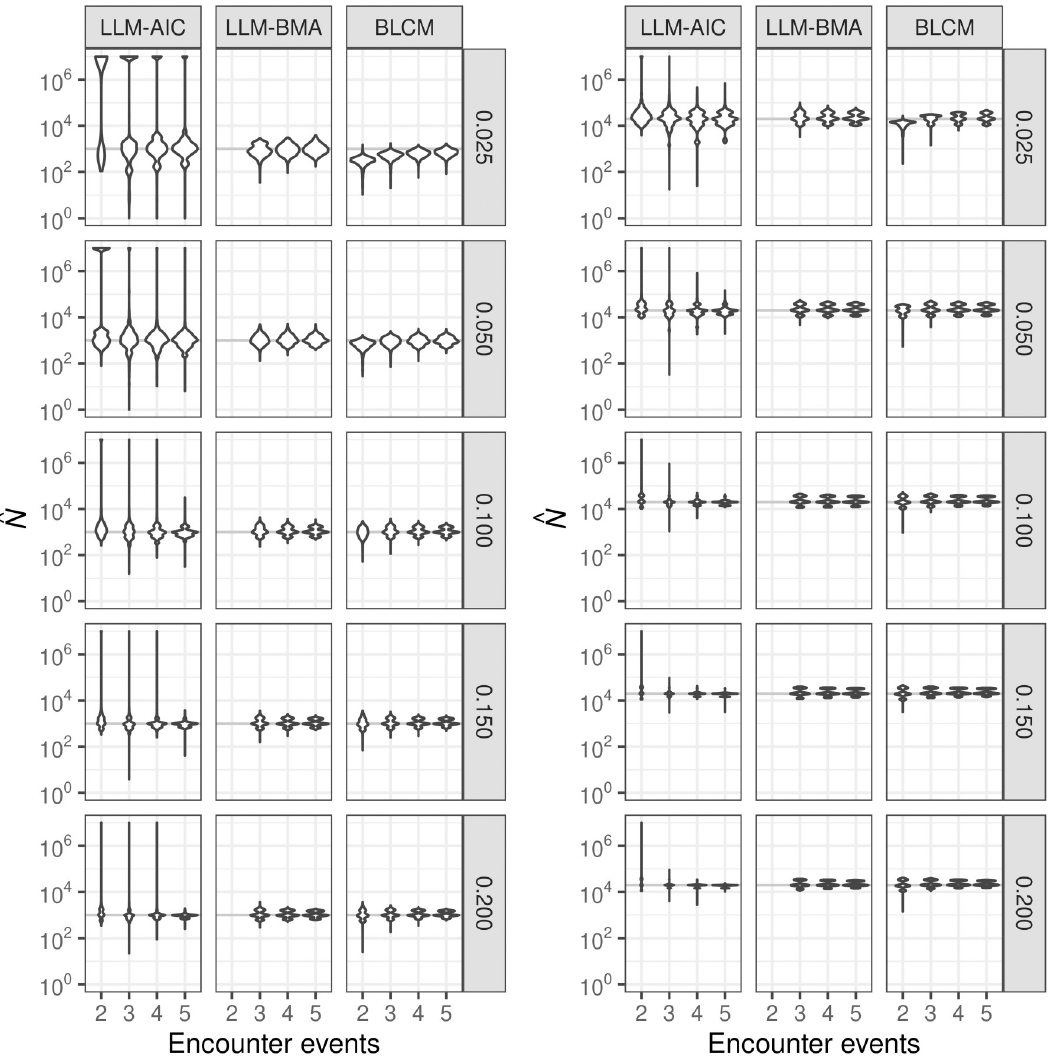
Fig 2. Distributions of estimates the sizes of populations consisting of 1,000 (left) and 20,000 (right) members. Estimation was based on 2–5 encounter event-histories generated from models M probabilities of 0.025, 0.050, 0.100, 0.150 and 0.200 (right margins). LLM-AIC denotes selection of the single best LLM based on AIC, LLM-BMA denotes Bayesian model-averaging of loglinear models, and BLCM denotes nonparametric Bayesian latent-class model estimation. Estimates larger than 10 7 are heaped at that value. Results for N = 10, 000 were similar to those for N = 20, 000.